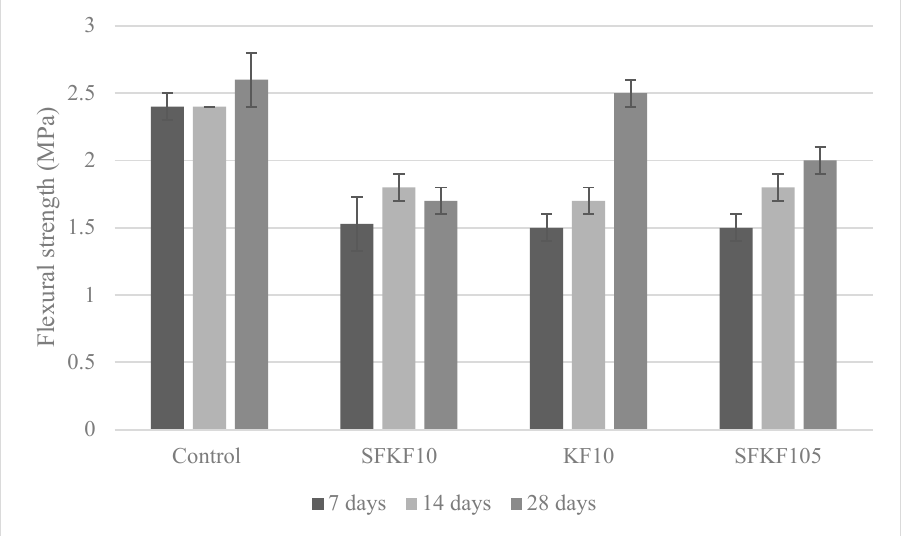
Figure 7. Variation of flexural strength .